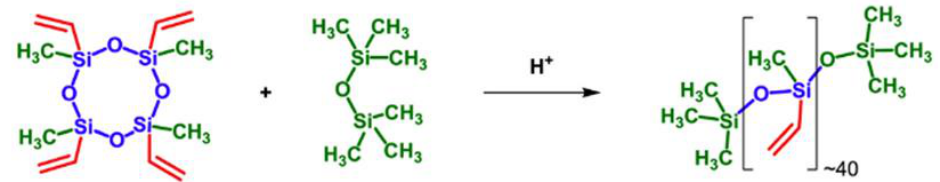
Figure 29. Synthesis of vinyl-containing precursor (/adapted with permission from Ref. [135]. 2018, Temnikov, M.N.).